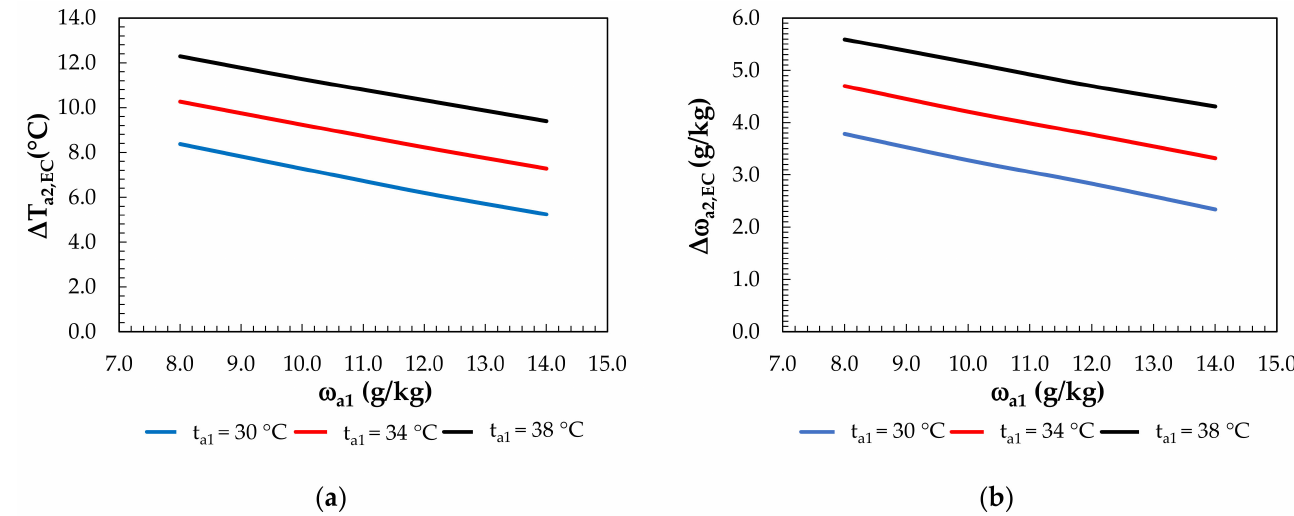
Figure 11. Effect of the inlet air humidity ratio for constant inlet air temperatures under air evapora- tive cooling: ( a ) on air temperature differences; ( b ) on the change in the humidity ratio. Mixing the streams (Figure 12) of dehumidified and evaporatively cooled air slightly decreased the temperature drop compared to evaporative cooling. The temperature drop ranged from 1.9 ◦ C to 9.7 ◦ C, with a corresponding decrease in the air humidity from 5.6 g/kg to 2.5 g/kg (at t a1 = 38 ◦ C, ω a1 = 8 g/kg). For t a1 = 30 ◦ C and ω a1 = 14 g/kg, there was slight air dehumidification of ∆ ω = − 0.6